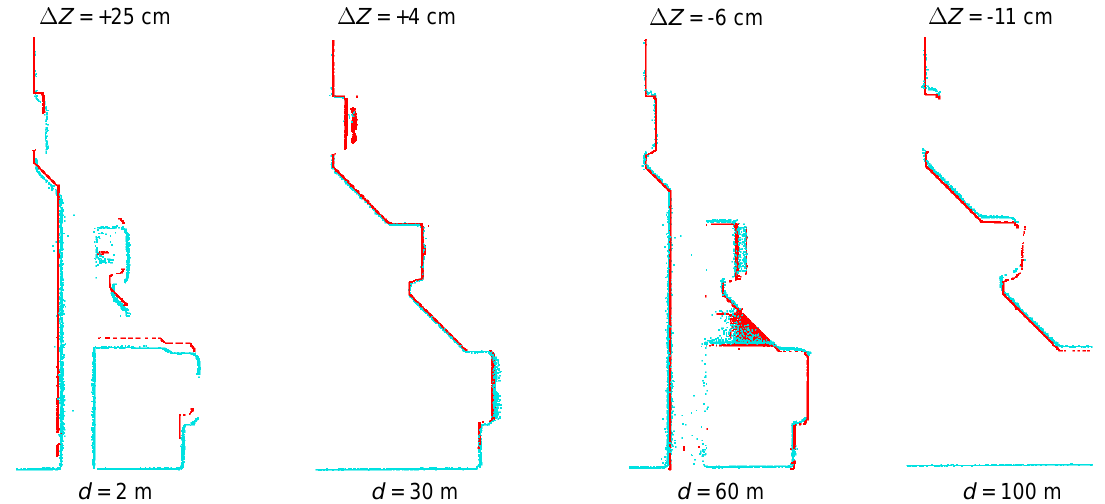
Figure 5. Vertical sections extracted at d = { 2 , 30 , 60 , 100 } m from the leftmost point of the facade. The HERON point cloud is shown in cyan, while the TLS one in red. Distances along the altimetric ( Z ) direction between the two models are reported above each section.